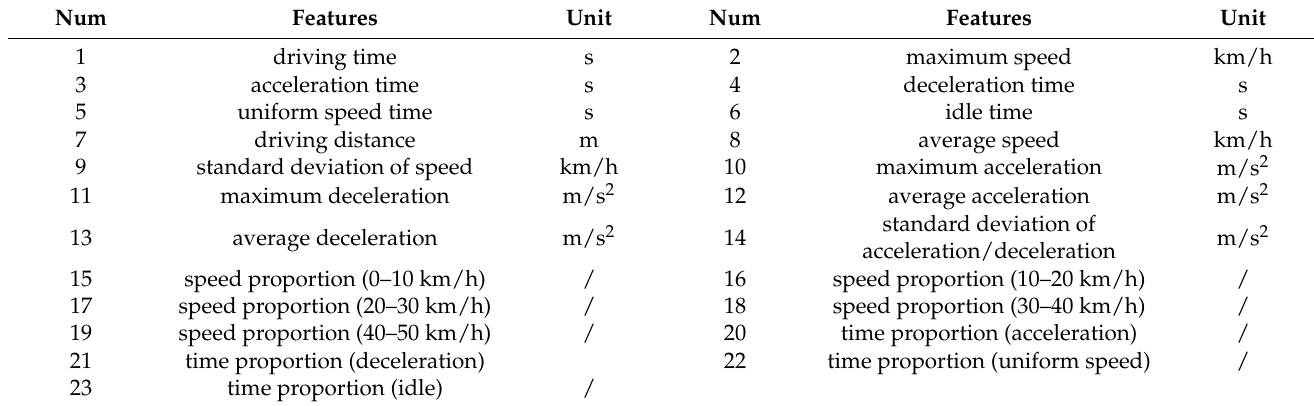
Table 4. Main vehicle parameters of the PHEV model.